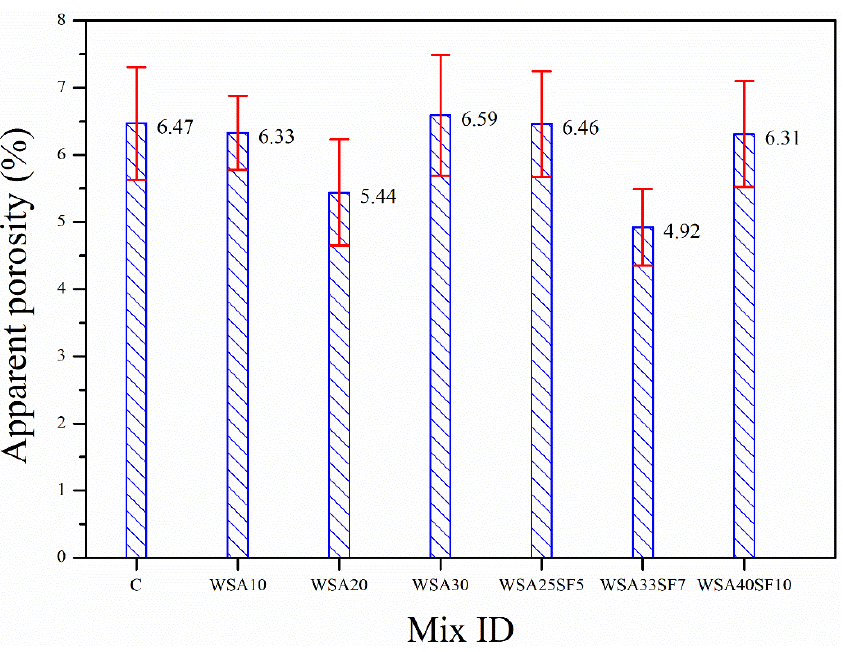
Figure 4. Comparison of the results for apparent porosity between control and other concretes (bi- nary and ternary mixes) after 91 days of standard